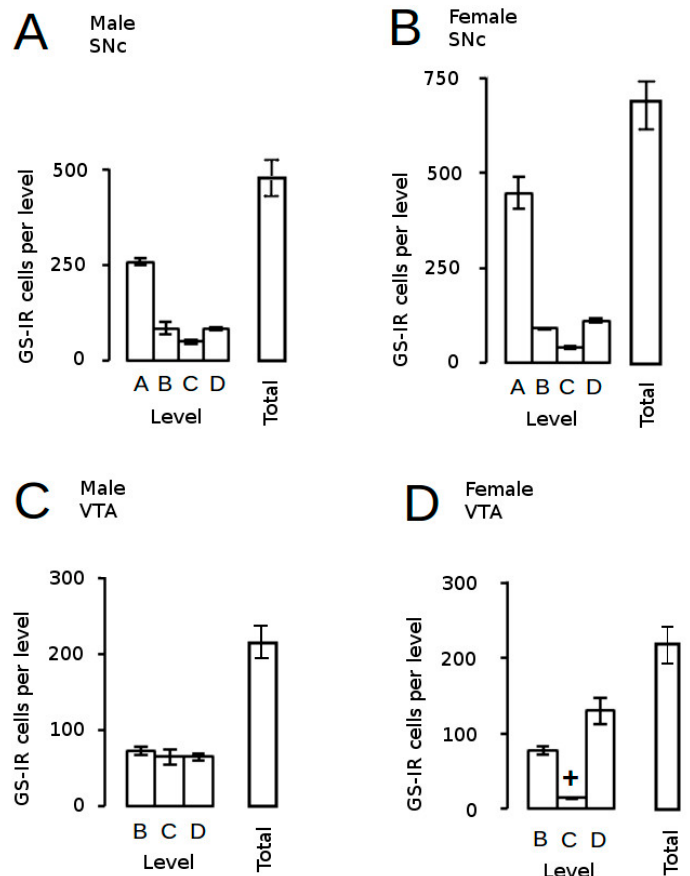
Figure 6. Estimated astrocyte counts in control rats. The distribution of astrocytes (GS-IR, immunoreactivity for glutamine synthetase) across the adult SNc ( A , B ) and VTA ( C , D ) and estimated total astrocyte counts are presented for male ( A , C ) and female ( B , D ) mice. + p < 0.05 for male vs. female. For fill details see [109].